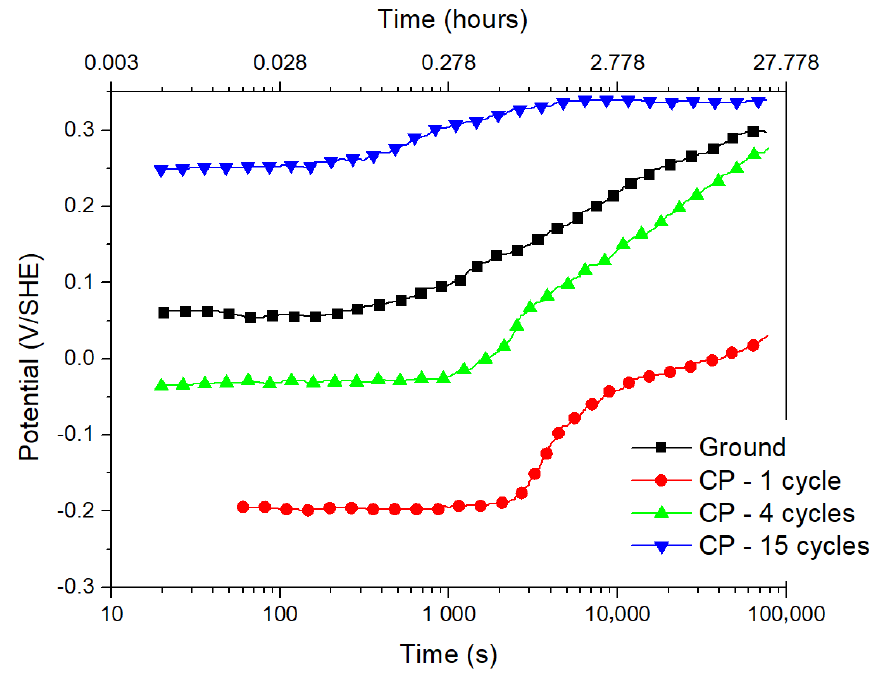
Figure 4. SKP monitoring of the potential of the above HSS 1500 steel in air after cathodic polarization in 0.1 M NaOH aqueous electrolyte with a current density of − 5 mA/cm 2 for different numbers of cycles. The reference HSS surface was measured after grinding.